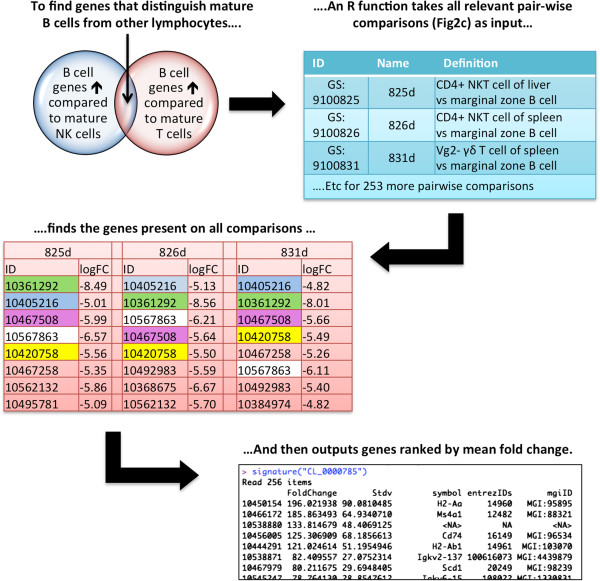
Finding genes that distinguish mature B cells from other mature lymphocytes. Names of the 256 pairwise comparisons identified in Figure 2C are entered into a custom R script. This script retrieves the gene lists from the file and finds common genes within all of the retrieved lists. Genes are ranked based on mean fold change across all the lists. Genes are outputted on screen (depicted) and as Excel files.